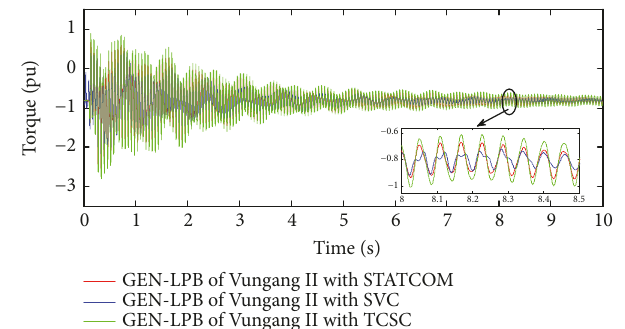
Figure 19: Comparison of the three proposed